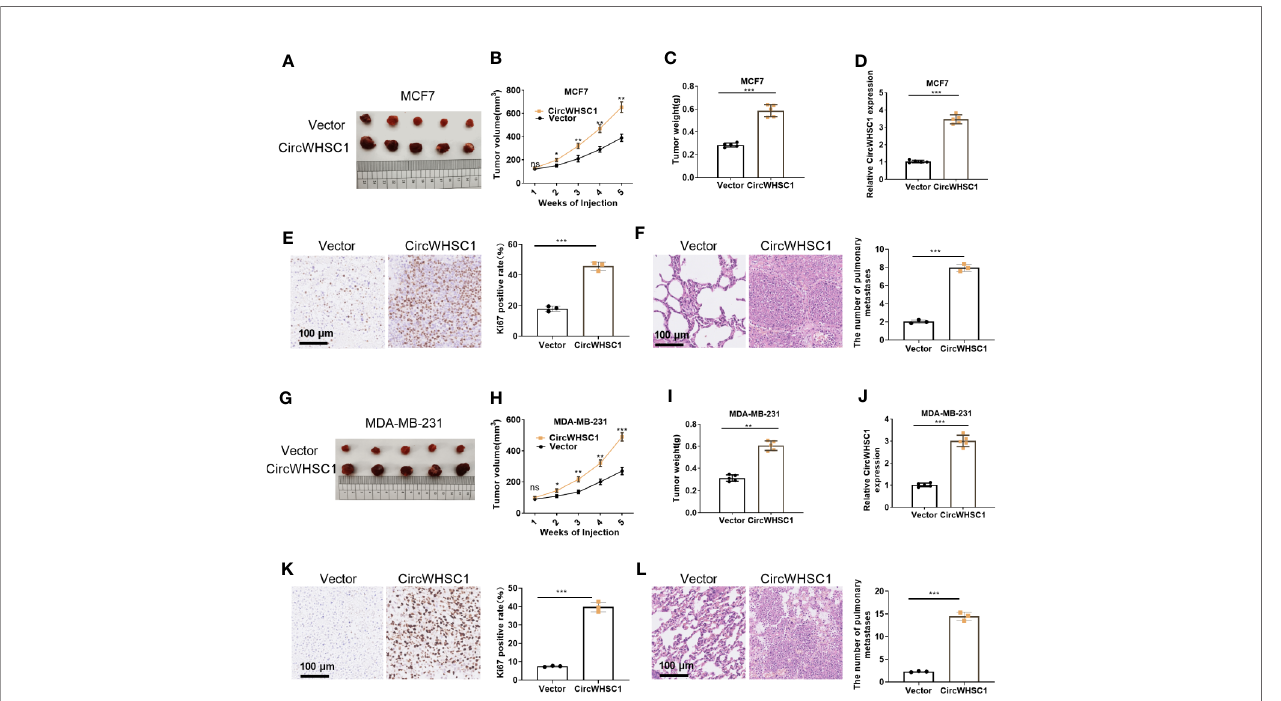
FIGURE 3 | Overexpression of circWHSC1 boosted BC cell growth in vivo. MCF7 cells were transfected with vector or CircWHSC1 overexpression plasmids and then subjected to constructing subcutaneous Xenograft models on nude mice. (A – D) Nude mice were sacri fi ced 5 weeks later, and subcutaneous tumors were extracted. Tumor volume (B) and weight (C) were calculated, and the expression of circWHSC1 was estimated by qRT-PCR (D) . (E) IHC detected KI67 expression in the tumors formed by MCF7 cells. (F) H&E staining examined lung metastasis of MCF7 cells. MDA-MB-231 cells were transfected with vector or CircWHSC1 overexpression plasmids and then subjected to constructing subcutaneous Xenograft models on nude mice. (G – J) Nude mice were sacri fi ced after 5 weeks, and subcutaneous tumor nodules were removed. The tumor volume (H) and weight (I) were calculated, and the expression of circWHSC1 was estimated by qRT-PCR (J) . (K) IHC checked the number of KI67-positive cells in MDA-MB-231 cells. (L) H&E staining monitored lung metastasis of MDA-MB-231 cells. ns P > 0.05, * P < 0.05, ** P < 0.01, *** P < 0.001 (vs.Vector group). N=5. scale bar=100 m